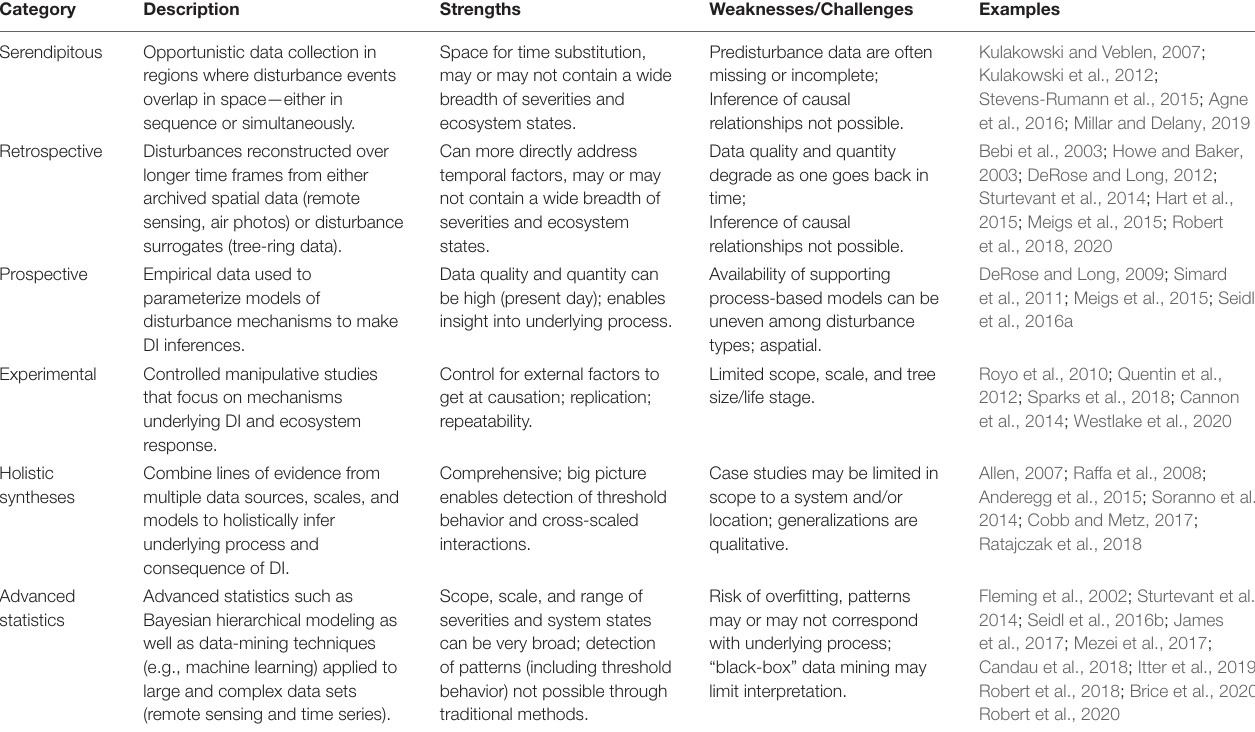
TABLE 1 | Strengths and weaknesses of alternative empirical approaches for investigating disturbance interactions